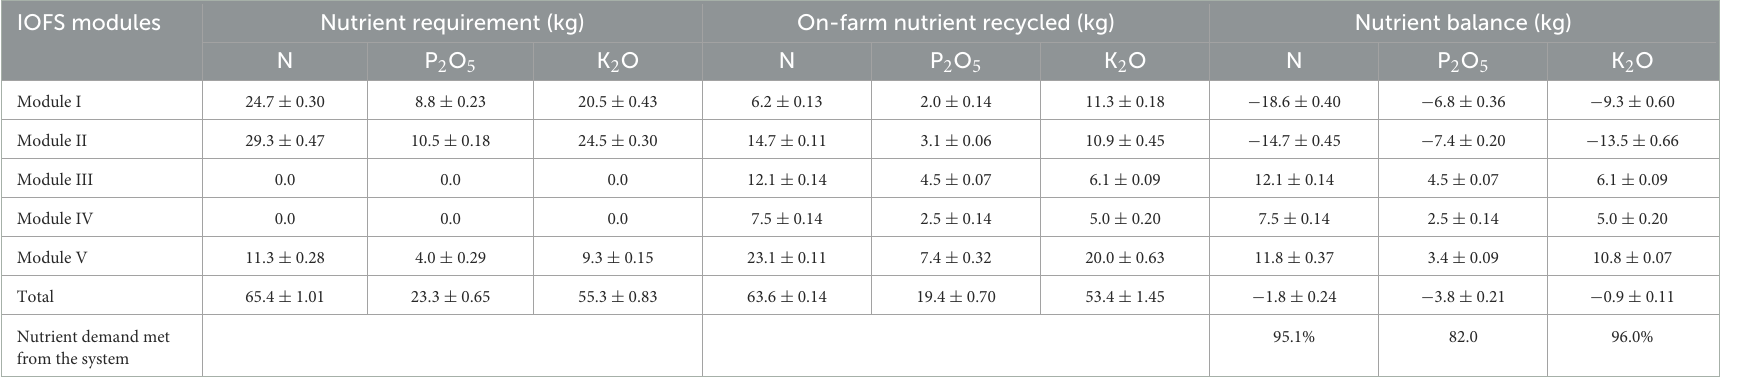
TABLE 5 On-farm nutrient supply balance sheet in the IOFS model of Mr. Jrill Makroh (after 5 years). IOFS modules